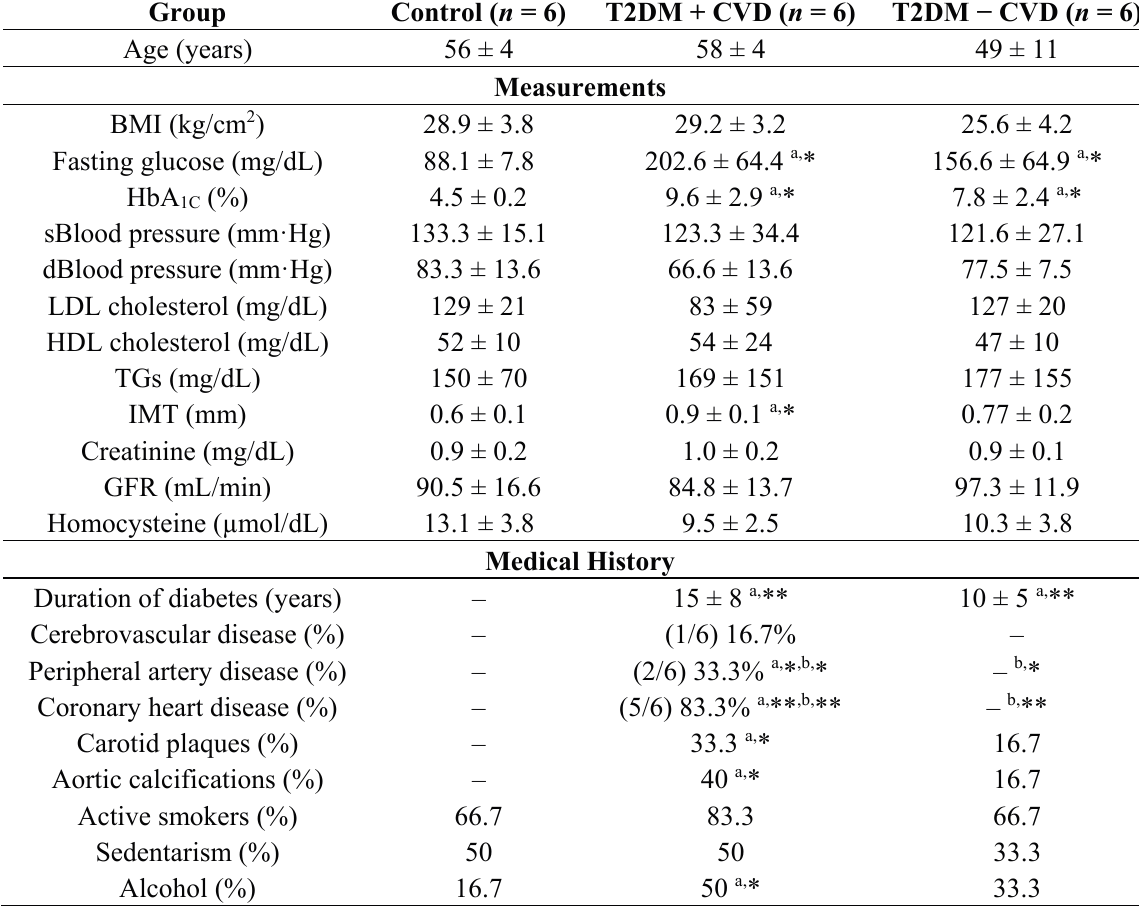
Table 1. Anthropometric and biochemical parameters of the study